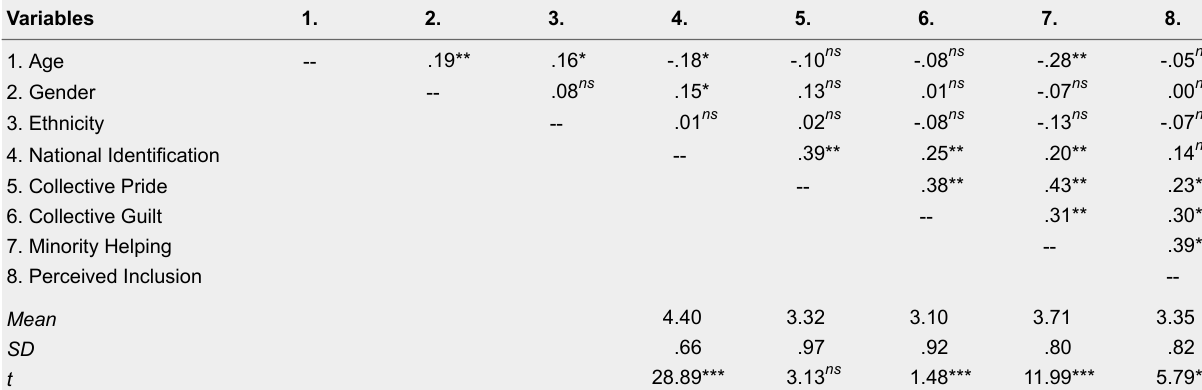
Descriptive Statistics and Correlations Among Variables in the